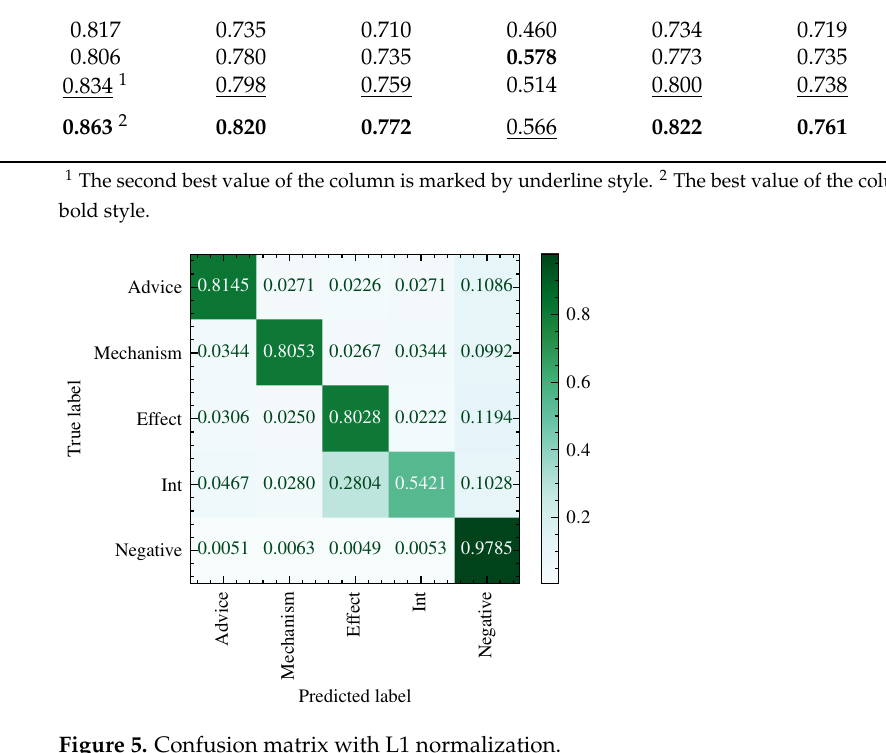
Figure 5. Confusion matrix with L1